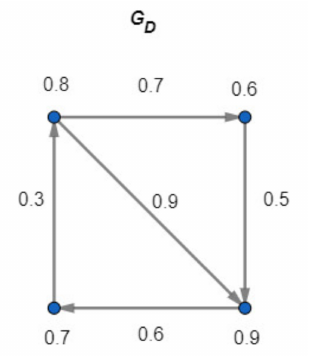
Figure 3. G D is not a fuzzy digraph.